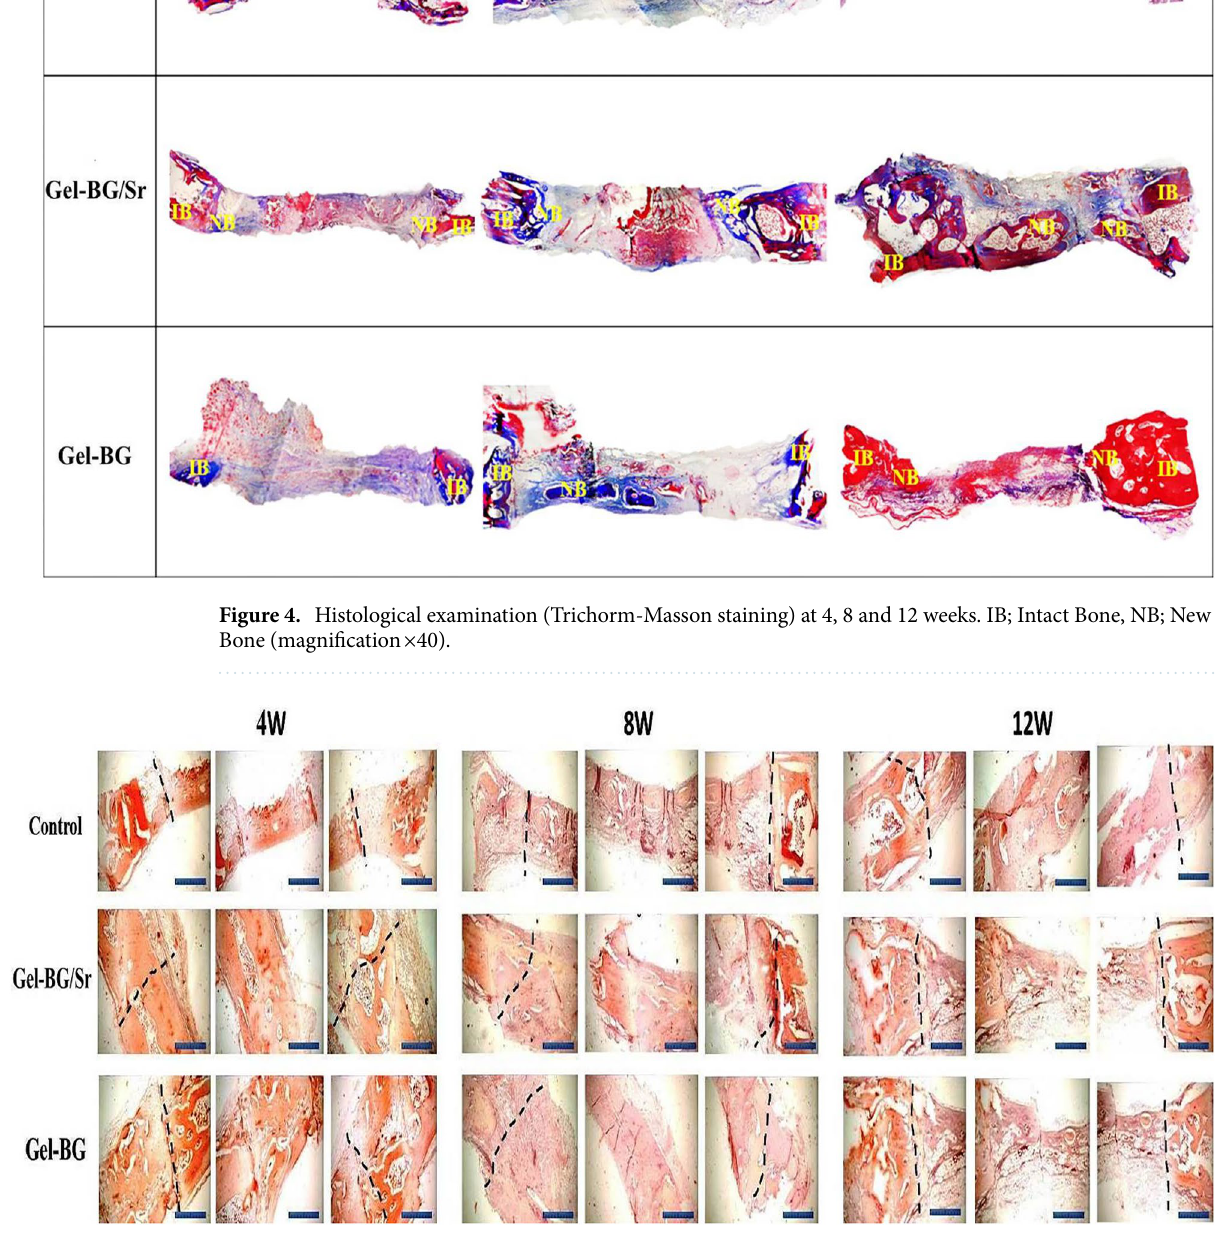
Figure 5. Histological examination (Alizarin red staining), showing the stages of mineralization of formed tissue after implantation of scaffolds at 4, 8 and 12 weeks. The dotted line indicates the border between intact bone and scaffolds (Scale bar: 10